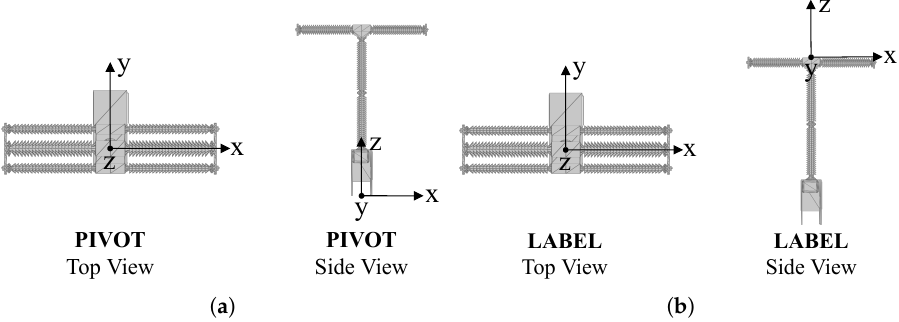
Figure 7. Demonstration of 3D modeling conventions: ( a ) positioning of the pivot in the mass center and the Z axis on the lowest point of the object; ( b ) positioning of the label in the mass center of the object and with Z axis on the uppermost